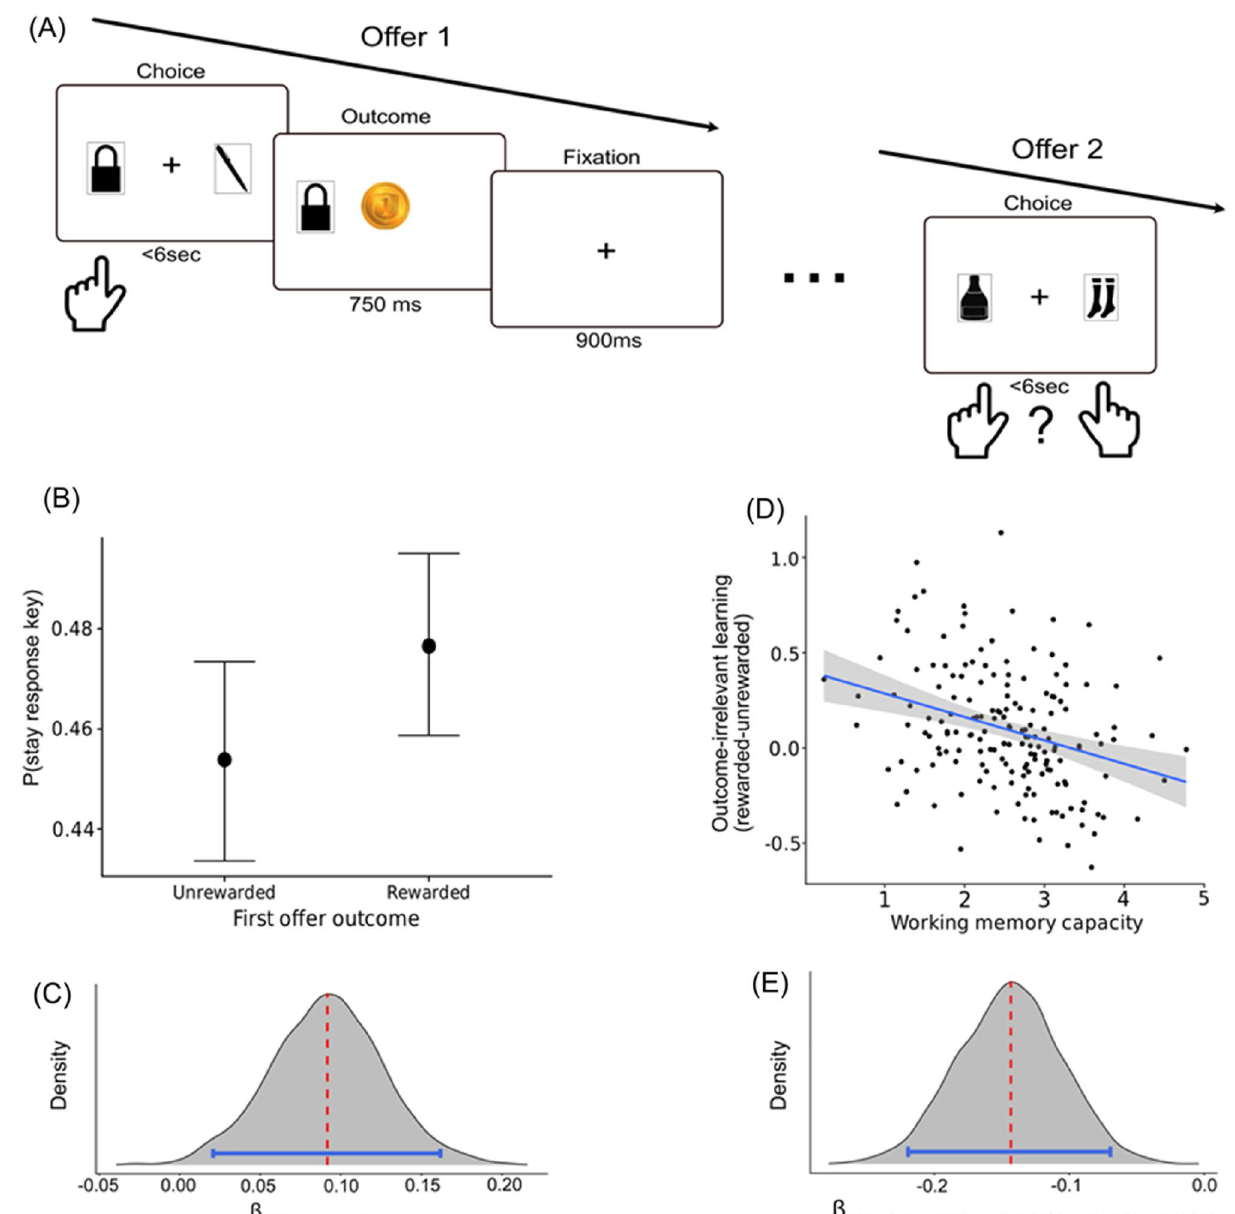
Figure 2. ( A ) Outcome-irrelevant learning was estimated as a tendency to stay with the previous response key selection as a function of previous-outcome (i.e., £0 vs £1), despite explicit knowledge that response keys did not predict outcomes in the task. ( B ) Marginal means estimates for response key stay probability show a greater stay tendency after reward vs. unrewarded trial, reflecting group level outcome-irrelevant learning (error bars represent HDI 95% ). ( C ) Posterior distribution for the regression coefficient of previous-outcome effect on response key stay probability describing group level outcome-irrelevant learning (red/blue lines indicate median/HDI 95% , respectively). ( D ) Outcome-irrelevant learning differed substantially between individuals and was moderated by working memory capacity estimates. ( E ) Posterior distribution for the regression coefficient indicating the moderation effect (i.e., paired interaction) between previous-outcome and working memory capacity (red line showing the posterior median and blue lines the HDI 95%